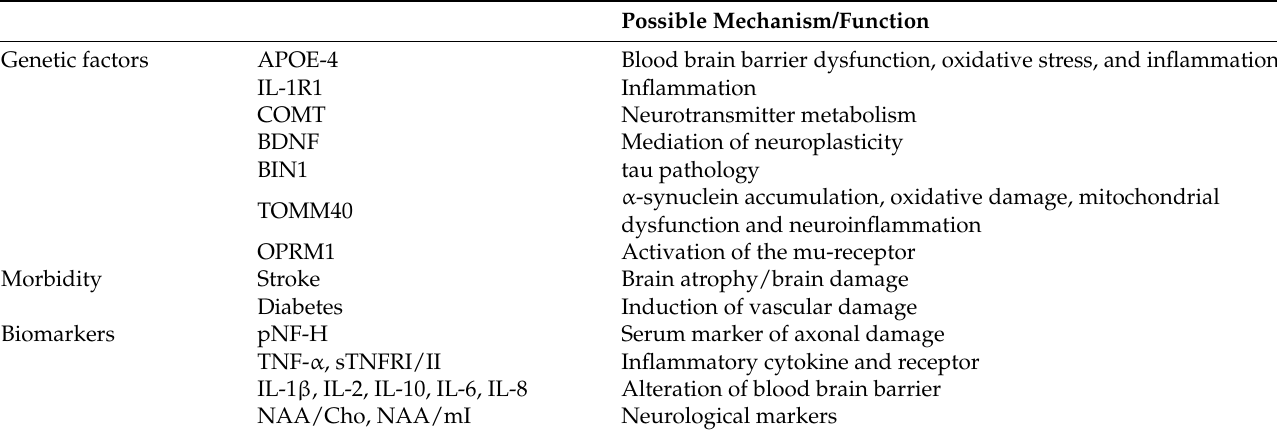
Table 3. Factors predisposing patients to dementia following cancer